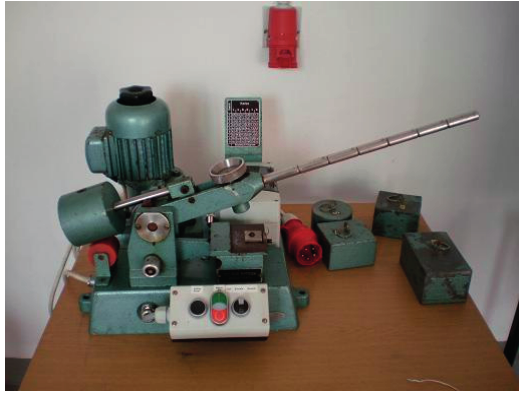
Figure 11. BAM friction test setup used in this